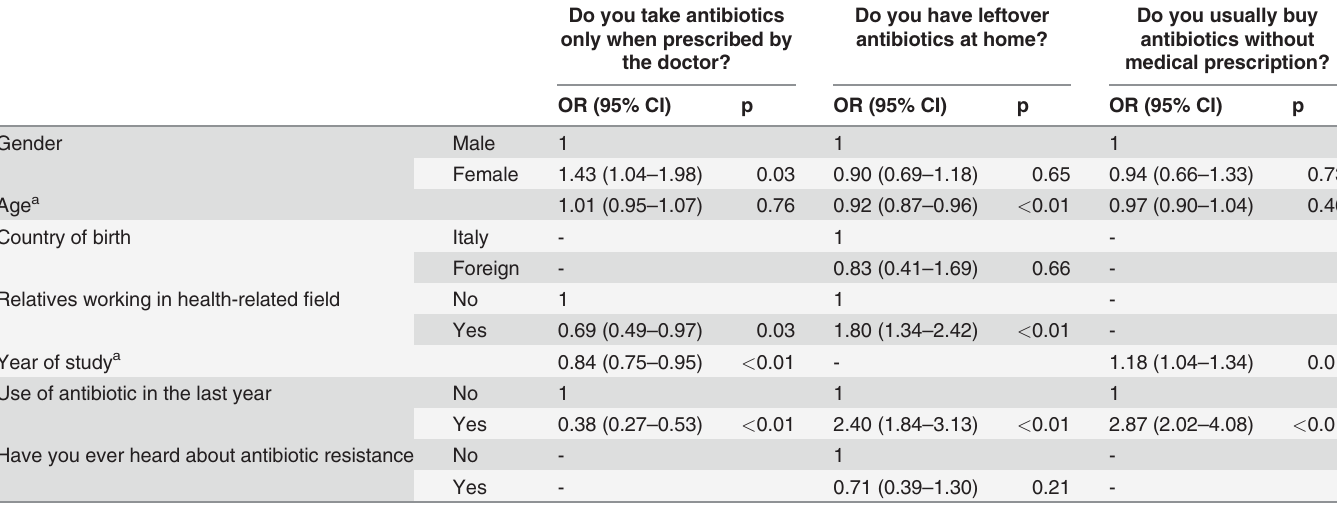
Table 3. Multivariate results on attitudes and behaviors about antibiotic consumption (N =